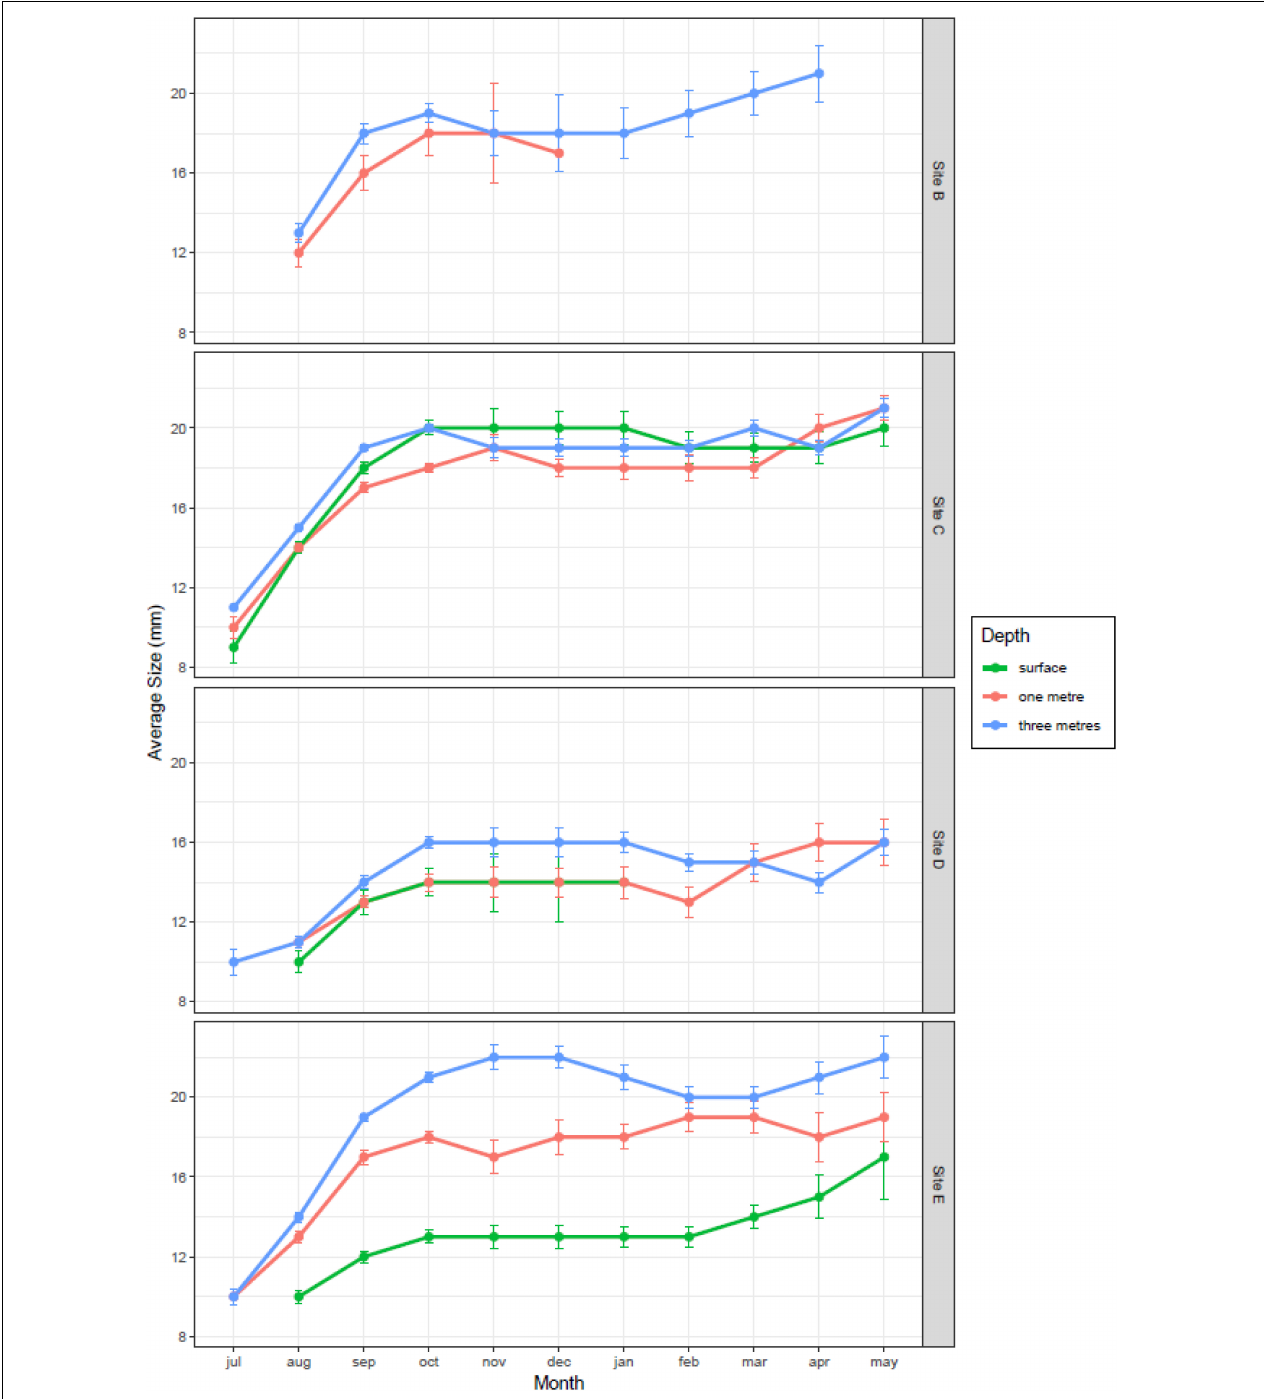
FIGURE 6 | Growth trajectories of zebra mussel at different depths and locations in Cardiff Bay (mean ± 95CI).